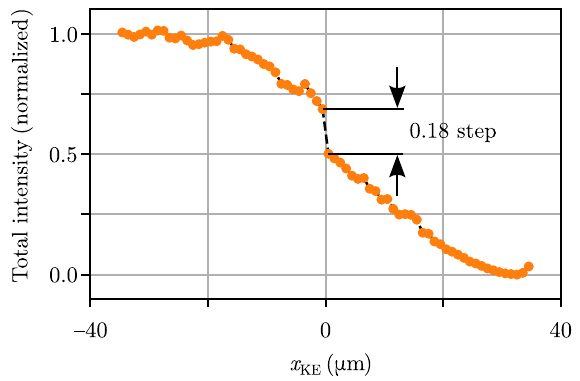
FIG. 5. Simulated nanofocus for various relative spectral bandwidths. Blue line, monochromatic light at the seventh harmonic; orange circles, a Gaussian spectrum about the center wavelength with 1.1% relative energy half-spread ( 1 =e 2 ). This bandwidth corresponds to that measured experimentally. Green dots: a fivefold increase of bandwidth results in a modest 10% widening of the